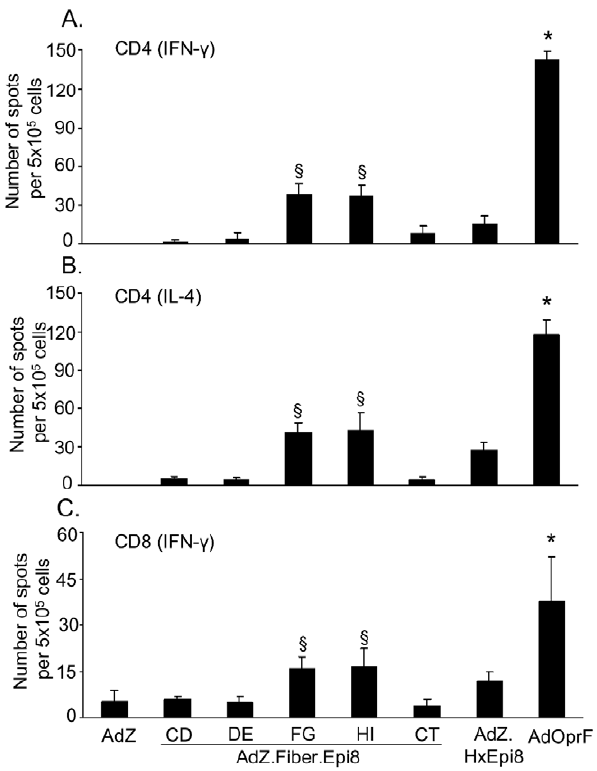
Figure 7. Immunization with Epi8 fiber-modified Ad vectors induces anti- P.aeruginosa cellular immunity. BALB/c mice were immunized via the intramuscular route with the fiber-modified Ad vectors AdZ.F(CD)Epi8, AdZ.F(DE)Epi8, AdZ.F(FG)Epi8, AdZ.F(HI)Epi8 and AdZ.F(CT)Epi8, the hexon-modified AdZ.HxEpi8, AdOprF or AdZ (all 10 10 pu/mouse) and boosted with the same vectors at 2 and 5 wk. Splenic CD4 and CD8 T cells were isolated 7 days following the last administration and incubated in vitro with syngeneic DC pulsed with recombinant OprF or DC alone. IL-4 and IFN- c were determined by ELISPOT assay. A. CD4 IFN- c ; B. CD4 IL-4; C. CD8 IFN- c . The data represent the mean of pooled cells from five mice per group from three separate experiments 6 SEM. * denotes p , 0.05, AdOprF compared to all others. 1 denotes p , 0.05, AdZ.F(FG)Epi8 or AdZ.F(HI)Epi8 compared to AdZ, AdZ.F(CD)Epi8, AdZ.F(DE)Epi8, AdZ.F(CT)Epi8 or